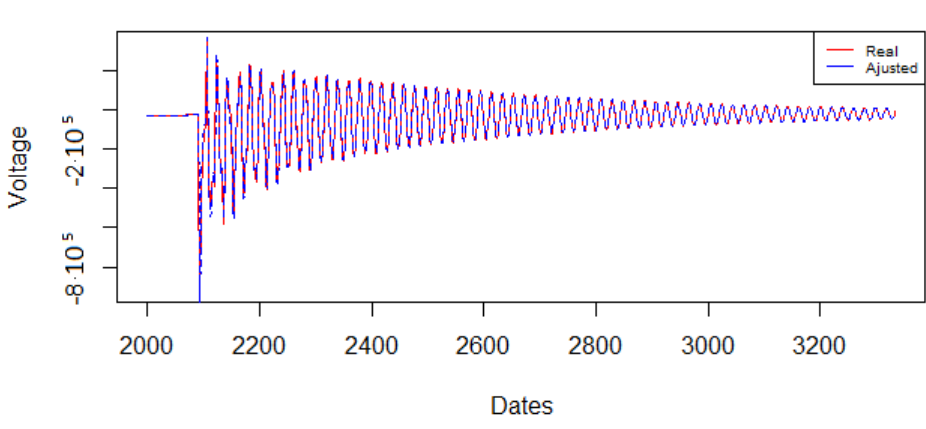
Figure 5. Missing data with distance of 10 km and with missing resistance of 240 Ω